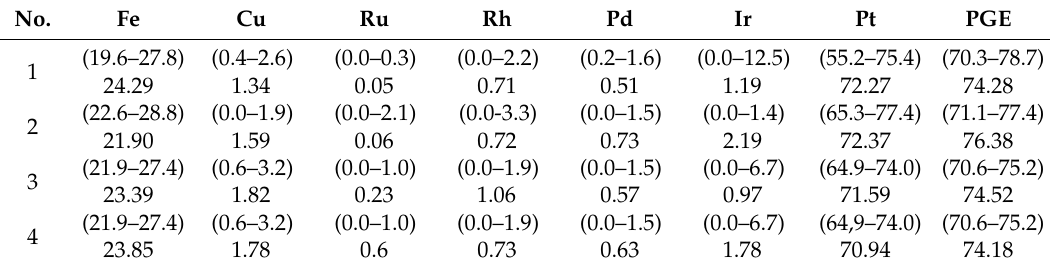
Table 7. Isoferroplatinum compositions from chromite-platinum ore zones of the Svetloborsky massif (1), the Vershinniy eluvial placer (2), the Travyanistyi proximal placer (3) and the Glubokinskoe distal placer